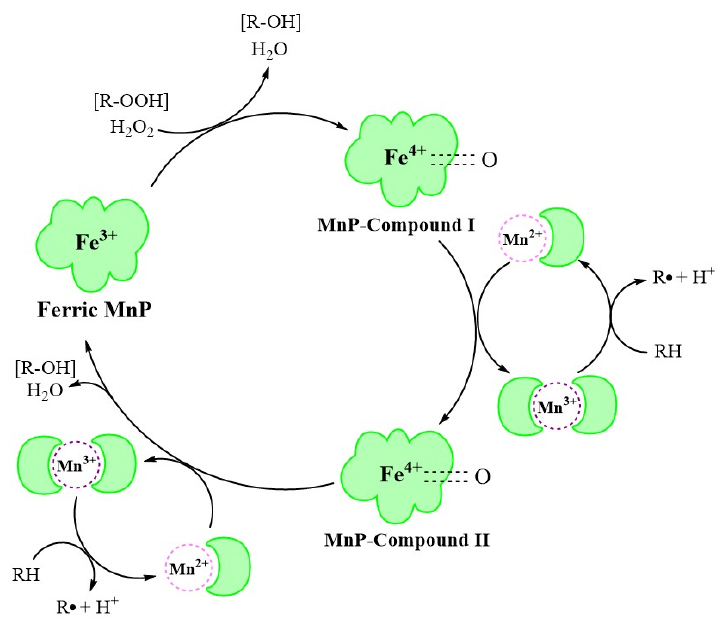
Figure 2. The MnP catalytic cycle [30].